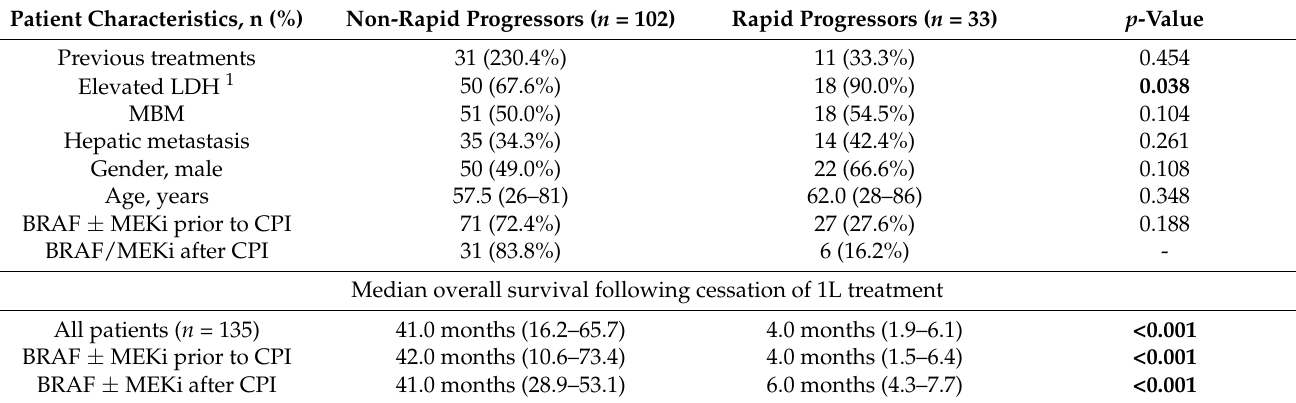
Table 4. Correlation between baseline factors and slow and rapid disease progression.